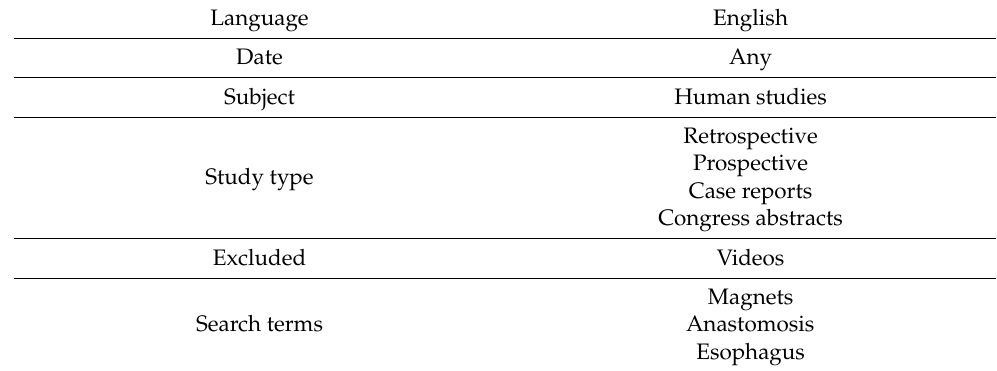
Table 1. Inclusion